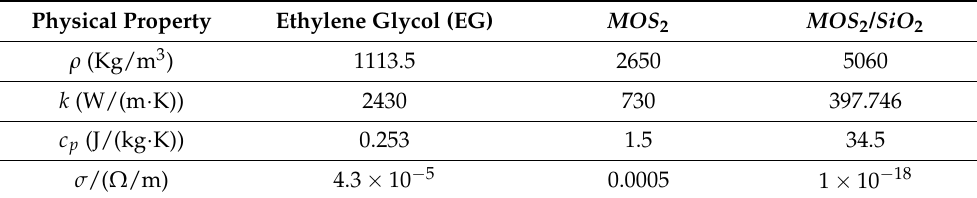
Table 1. Values of properties of nano-structures and hybrid nano-structures. Physical Property Ethylene Glycol